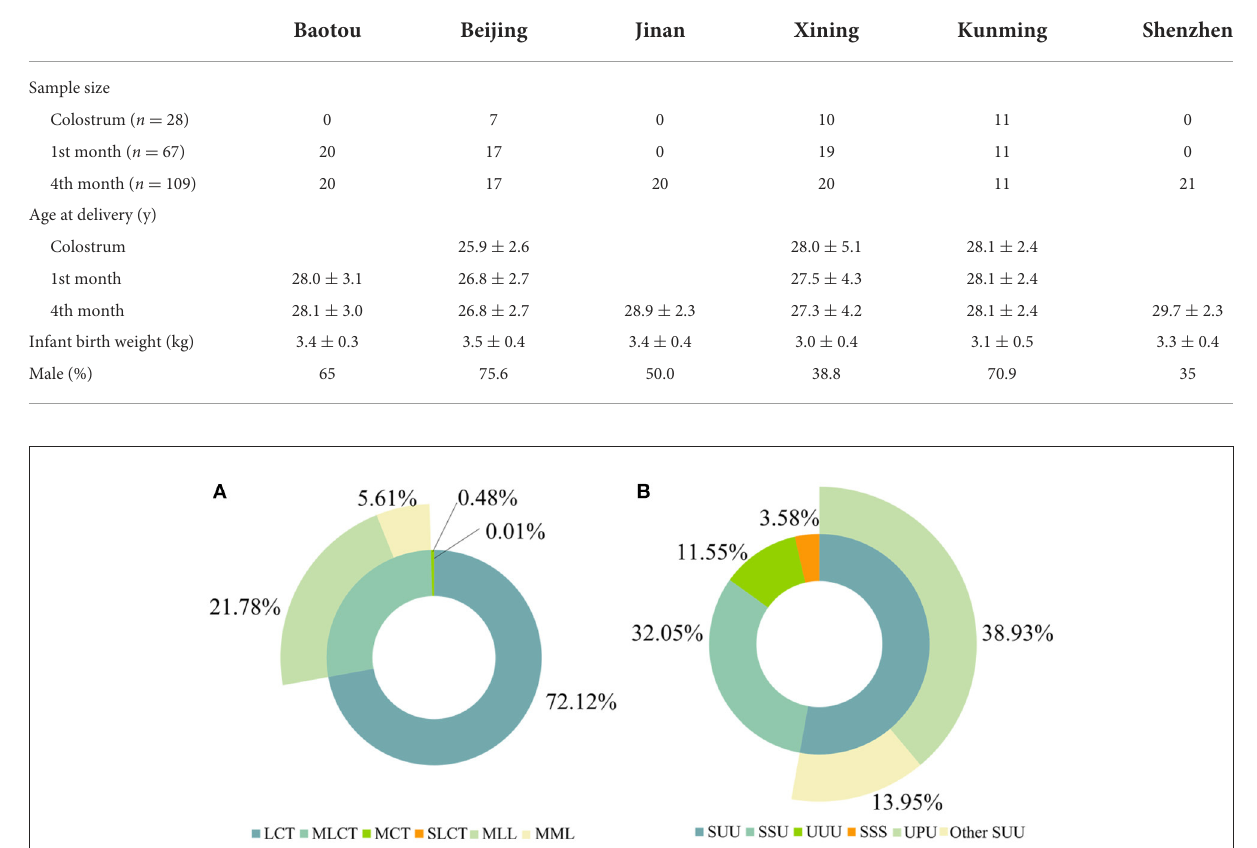
TAG analysis using